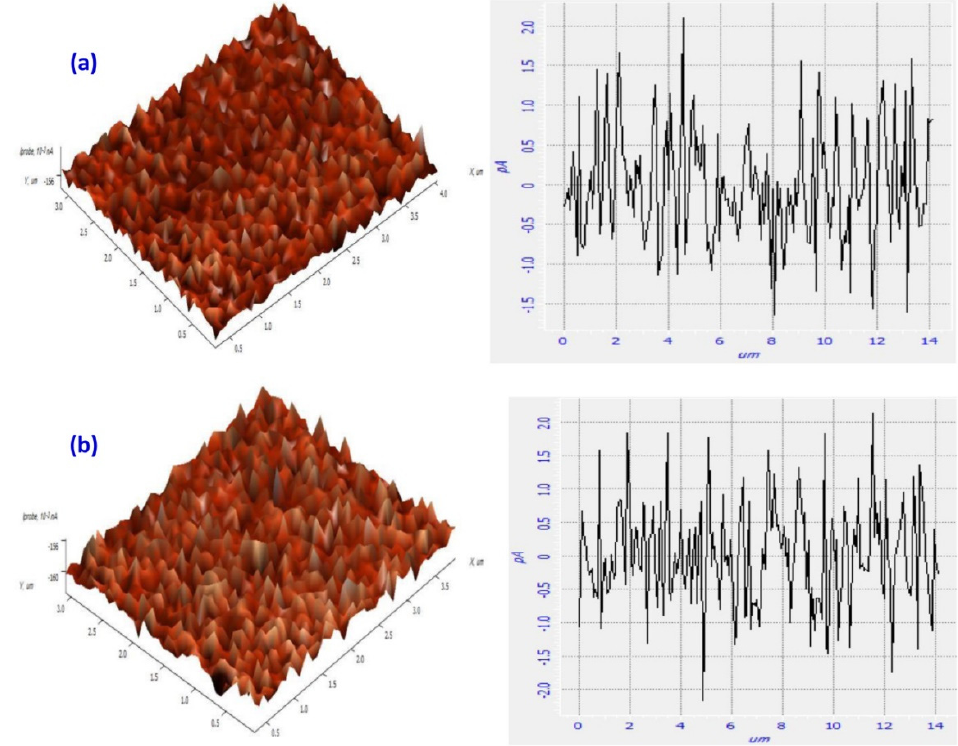
Figure 17. Scanning tunneling microscopy (STM) images and height profiles of methylcellulose-based polymer electrolyte ( a ) before H 2 S treatment, ( b ) after H 2 S treatment [87]. (Reprinted with permission from Abdullah et al.,